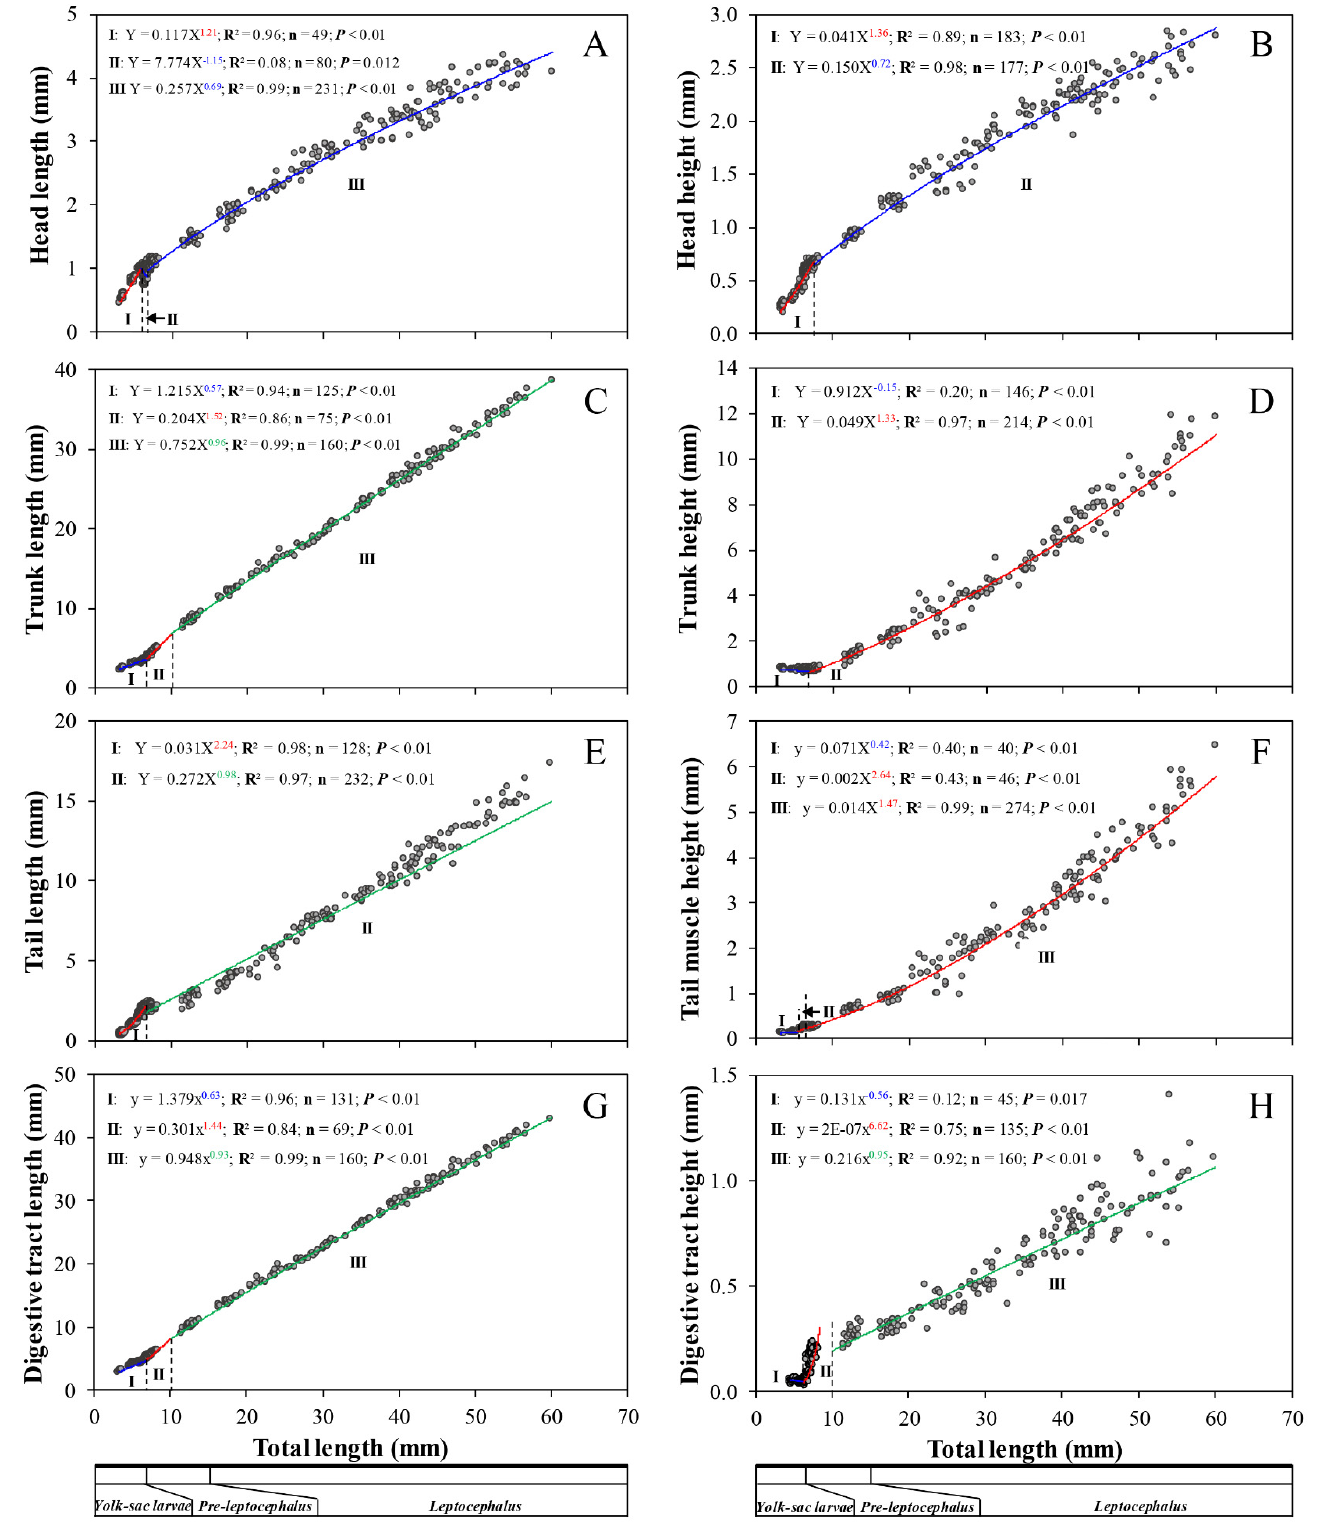
Figure 9. Allometric growth equations between measured body proportions from 0 to 200 DAH in Anguilla japonica larvae. ( A ) Head length. ( B ) Head height. ( C ) Trunk length. ( D ) Trunk height. ( E ) Tail length. ( F ) Tail muscle height. ( G ) Digestive tract length. ( H ) Digestive tract height. The dashed lines represent the inflexion points of growth. Abbreviation: DAH, days after hatching.